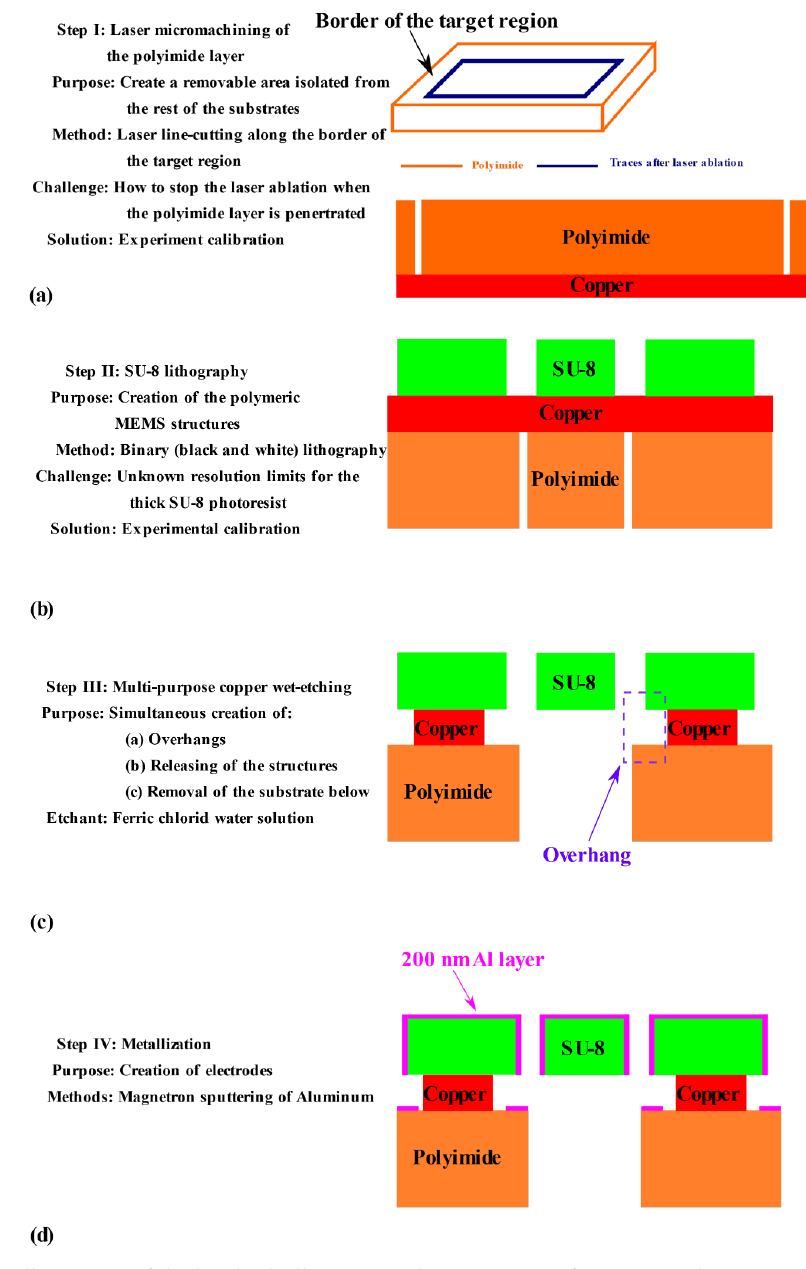
Figure 2. Illustration of the border-bulk micromachining process for SU-8 in-plane MEMS structures. ( a ) Direct micromachining of the polyimide layer; ( b ) SU-8 lithography on the surface of the copper layer; ( c ) Multi-purpose wet etching; ( d ) Metallization.